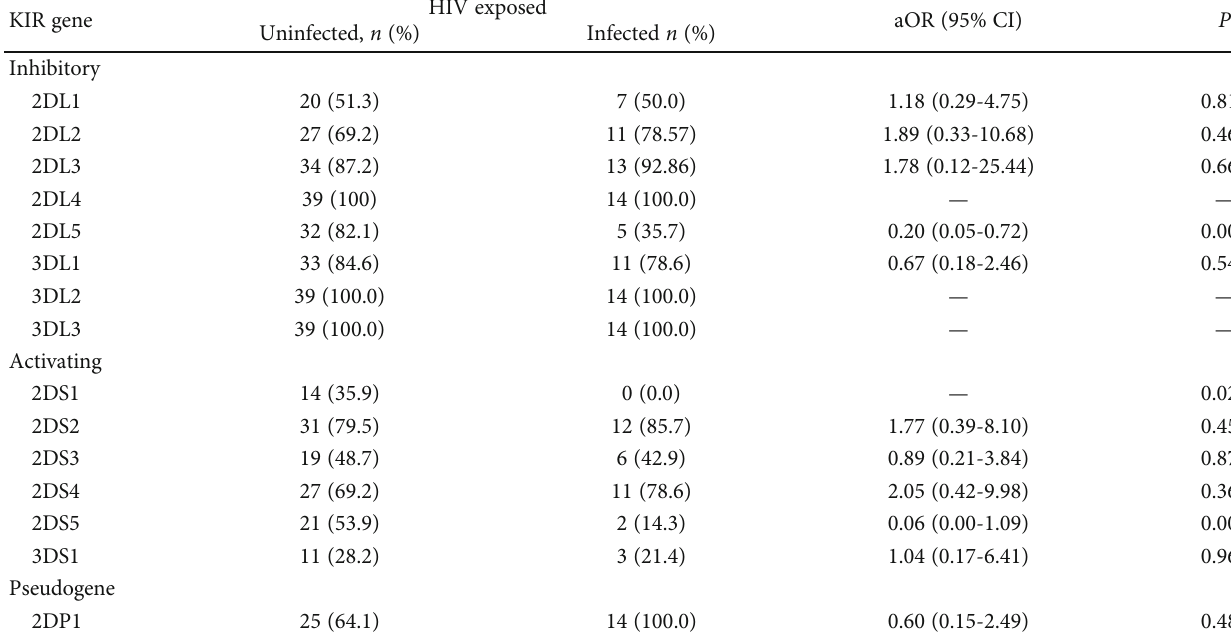
Table 3: KIR distribution among HIV-exposed